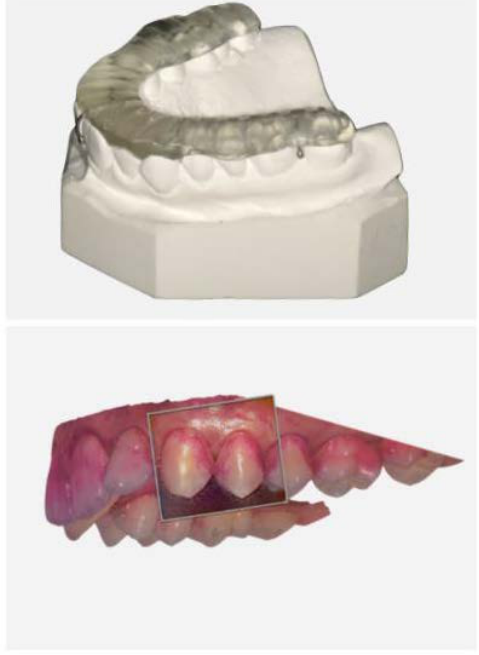
Figure 3. Representative oral splint applied during brushing to produce the foamy slurry of the test toothpastes and representative oral scan of the upper jaw (3Shape Trios, TRC; 3Shape, Copenhagen, Denmark) after four-day oral hygiene abstinence. The subjects were instructed to brush the rippled splint with the test toothpastes to avoid the actual mechanical intervention of the